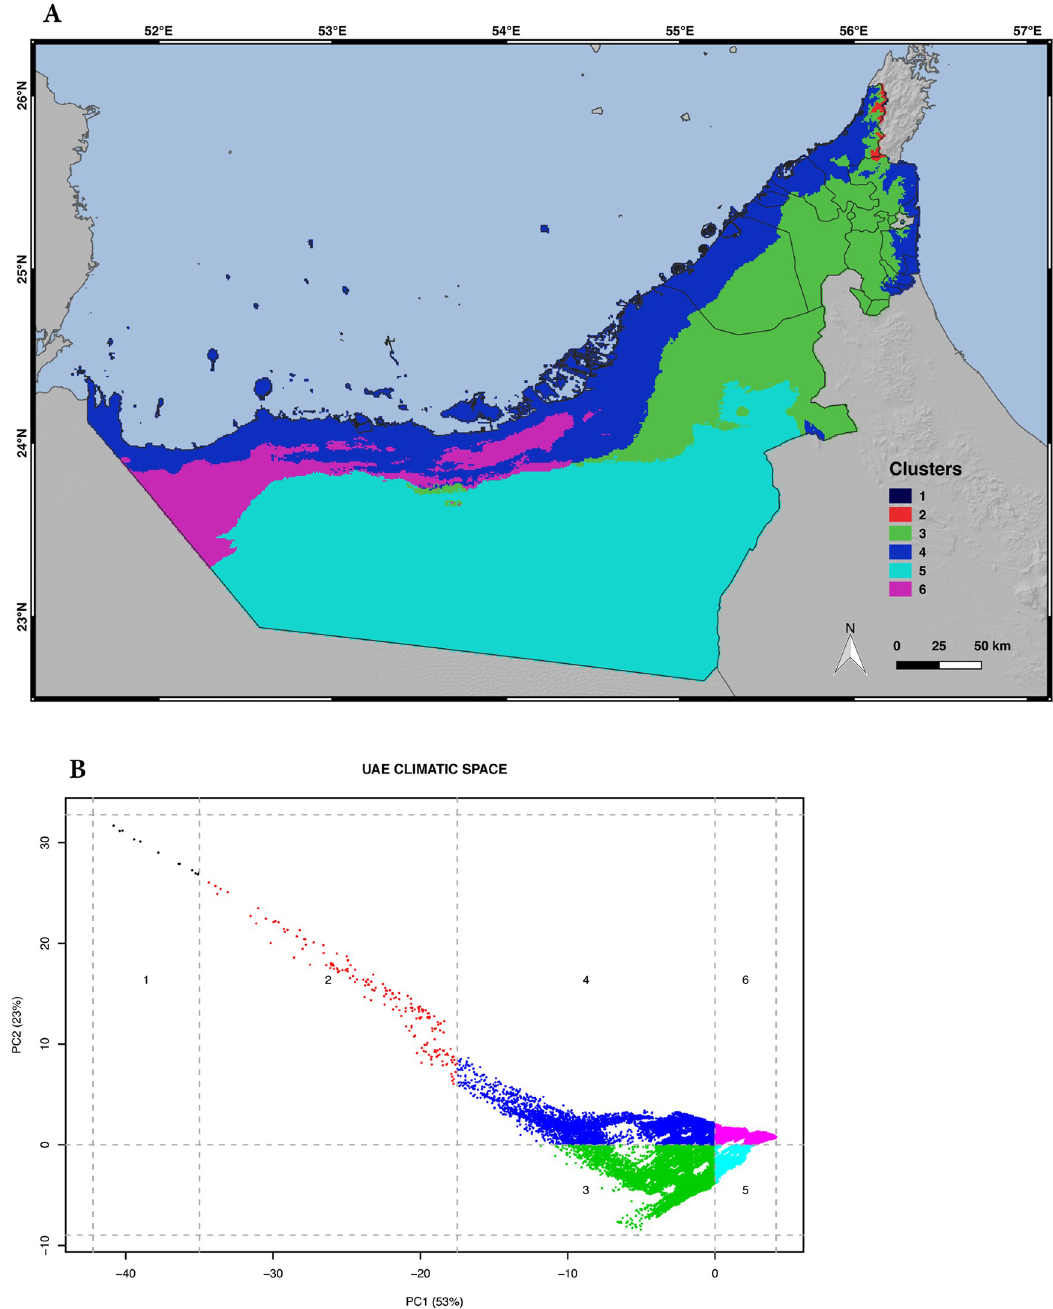
Fig 5. Climatic variability of the UAE. A) Map showing the distribution and extension of the six UAE climatic clusters; B) Principal component analysis (PCA) of the climatic space of the UAE (grey dots) using 19 bioclimatic variables from BIOCLIM with the climatic clusters numbered from one to six and colored with the same colors as in the map. Credits: OpenStreetMap contributors, SRTM.